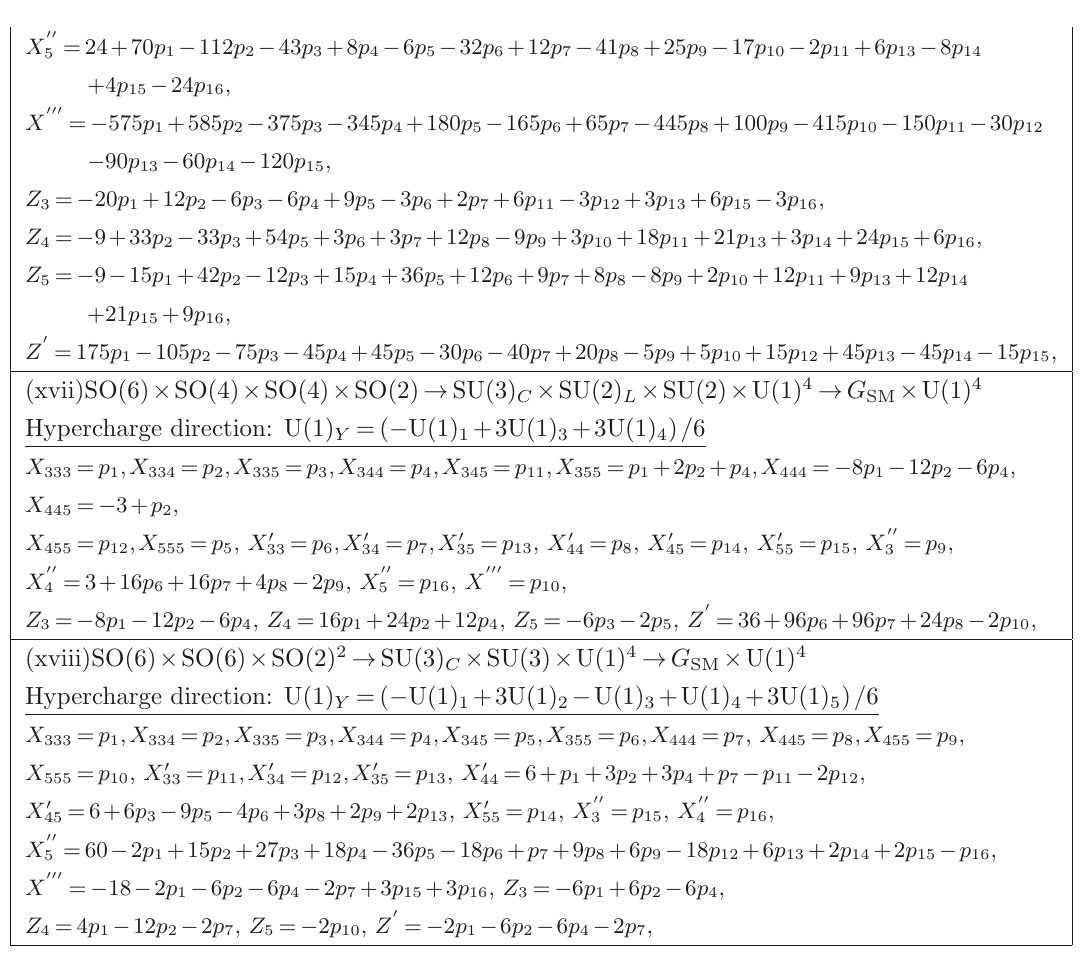
′′ ′′′ X ABC ,X ′ AB ,X ,Z A ,Z ′ with integers p m , leading to three- A ,X { }